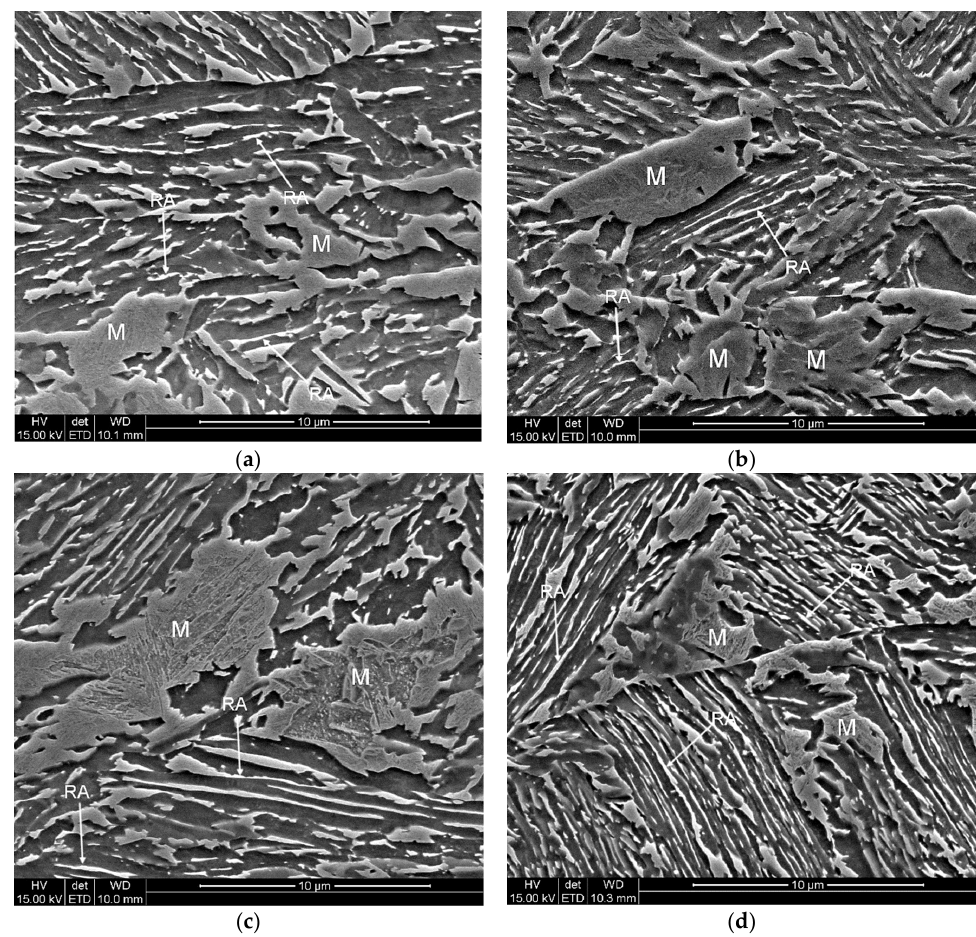
Figure 6. SEM micrographs of the specimens deformed at different temperatures: 20 °C ( a ), 60 °C ( b ), 100 °C ( c ), 200 °C ( d ). 100 ◦ C ( c ), 200 ◦ C ( d ).